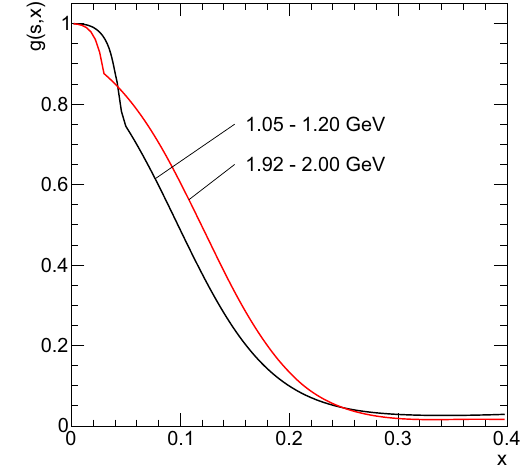
Fig. 3 The detection efficiency for e + e − → ωη → ηπ 0 γ events as a function of the normalized ISR photon energy for two energy intervals